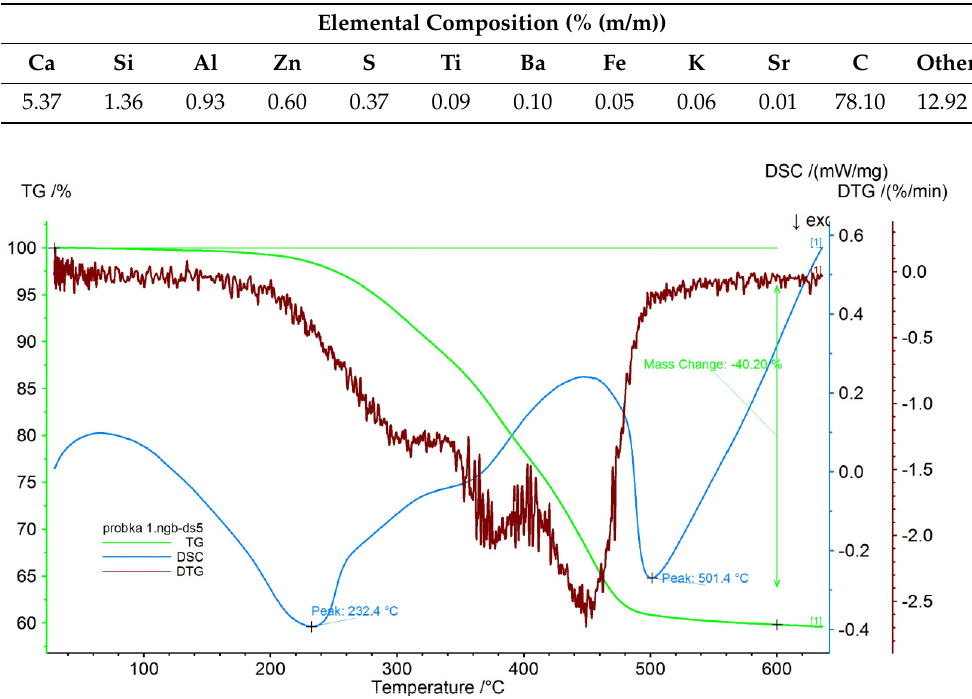
Table 2. The elemental composition of post-consumer waste, %.